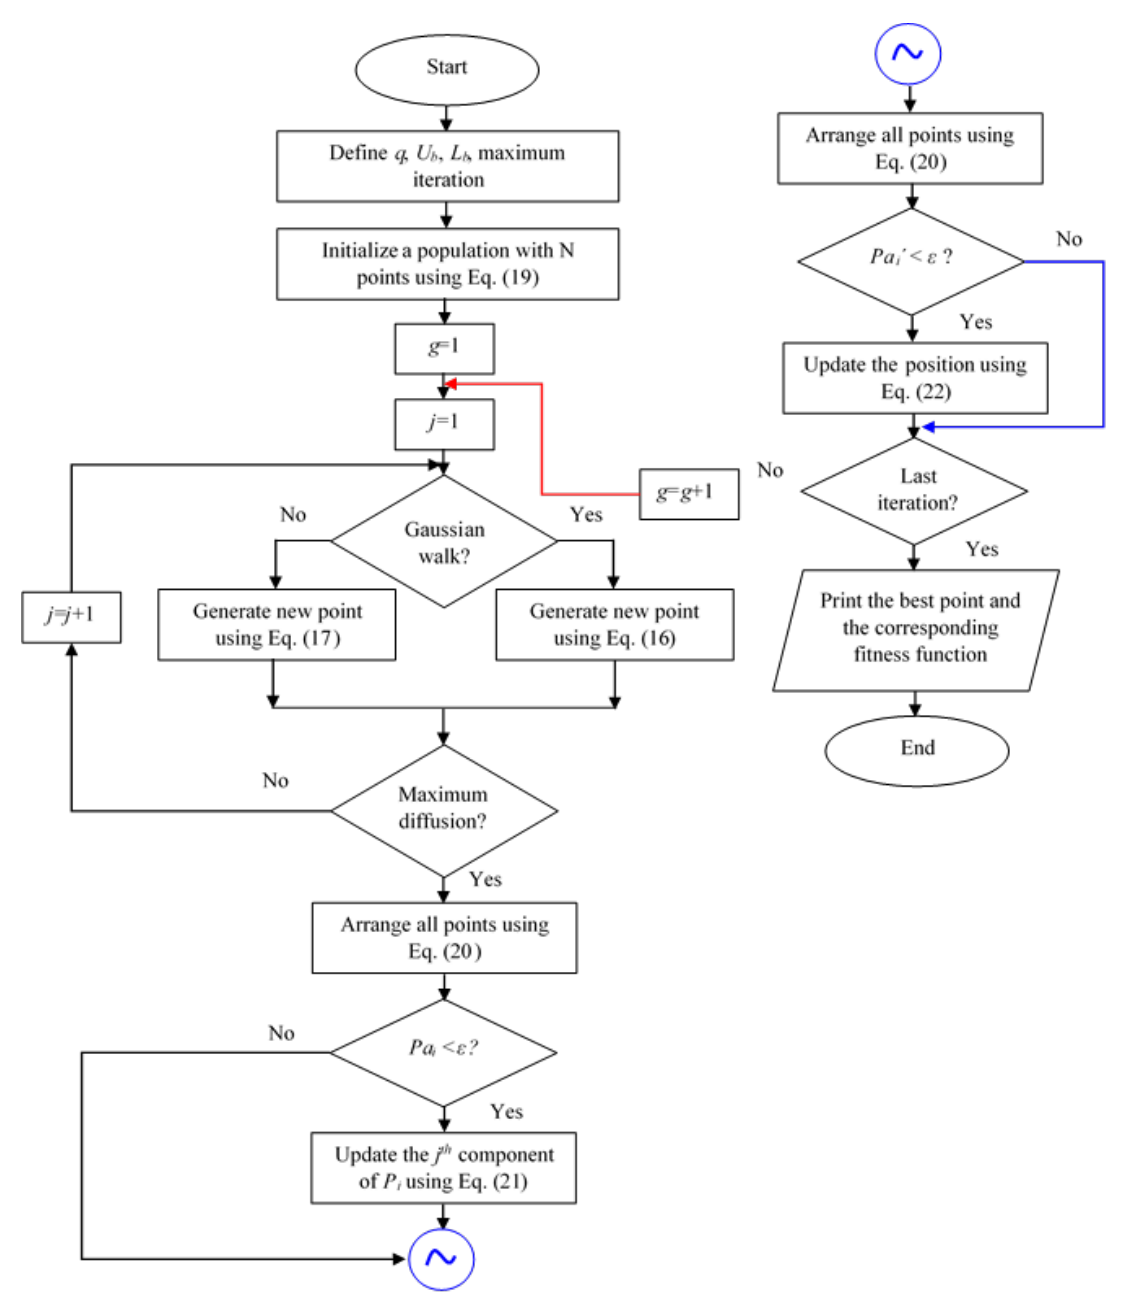
Figure 3. Flowchart of the optimization process of stochastic fractal search (SFS) optimizer.